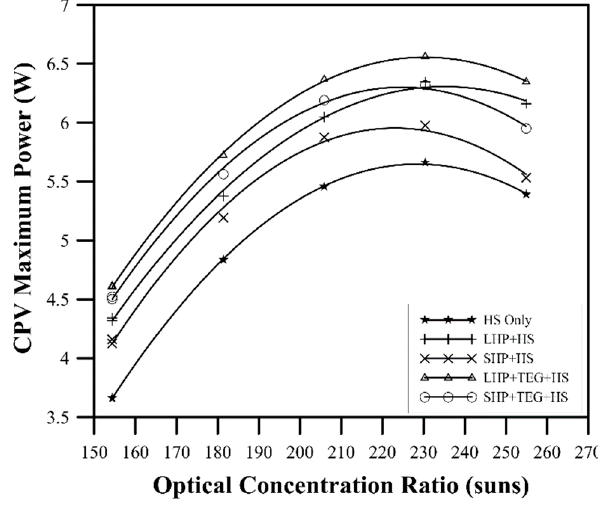
Figure 8. CPV maximum generated power as a function of the optical concentration ratio. Temperatures of the TEG hot sides for the two configurations having TEG elements short HP shows a higher temperature at the TEG side (HP condenser side). This indicates